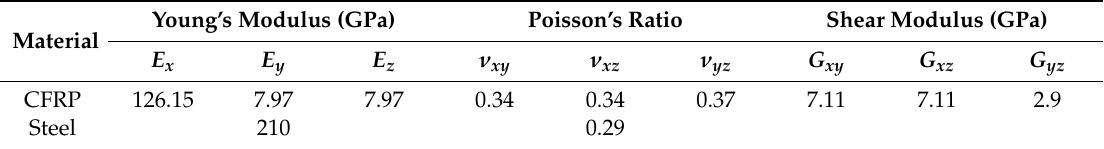
Table 1. Relevant properties considered for the hybrid component made of a unidirectional carbon fiber-reinforced plastic (CFRP) and